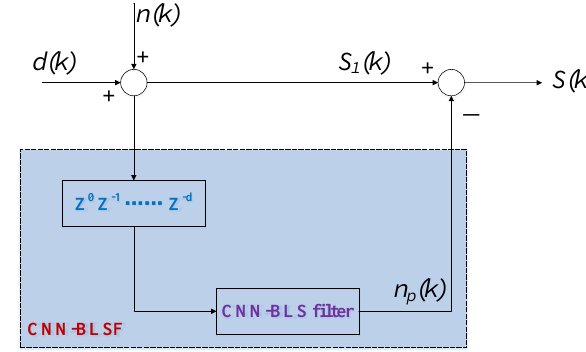
Figure 5. Mathematical model of the tremor